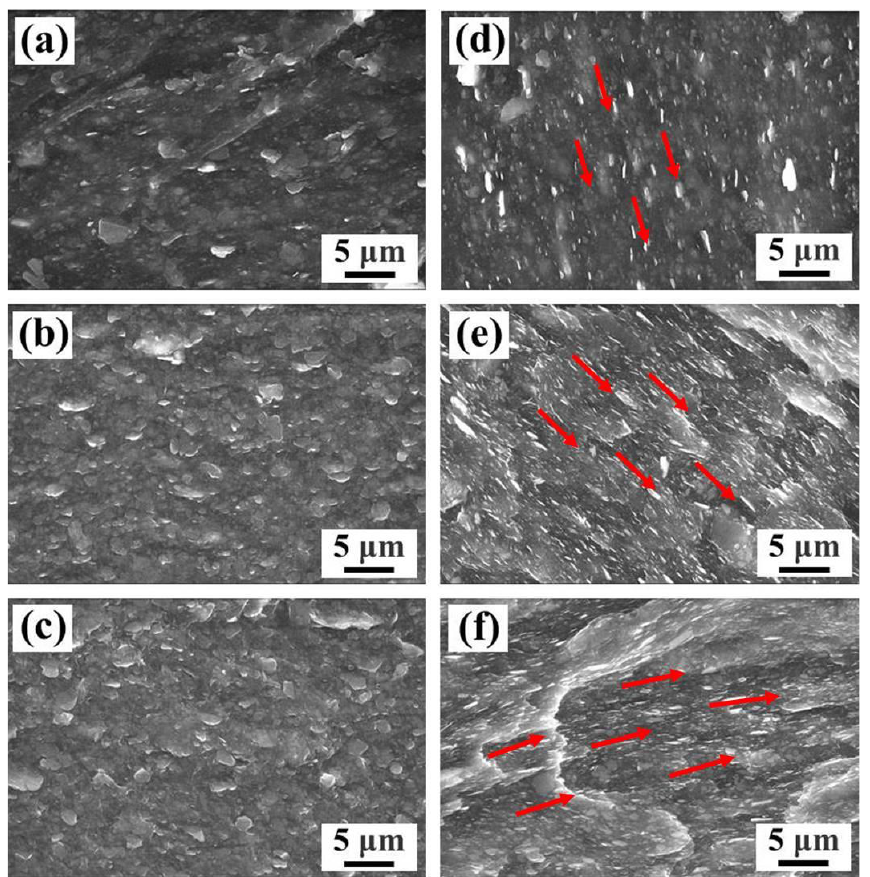
Figure 5. Cross-sectional SEM images of ( a ) 10 vol% hBN/XNBR, ( b ) 20 vol% hBN/XNBR, ( c ) 30 vol% hBN/XNBR, ( d ) 10 vol% mhBN@GO/XNBR, ( e ) 20 vol% mhBN@GO/XNBR, and ( f ) 30 vol% mhBN@GO/XNBR composites. The red arrows represent the orientated dispersion of mhBN@GO.